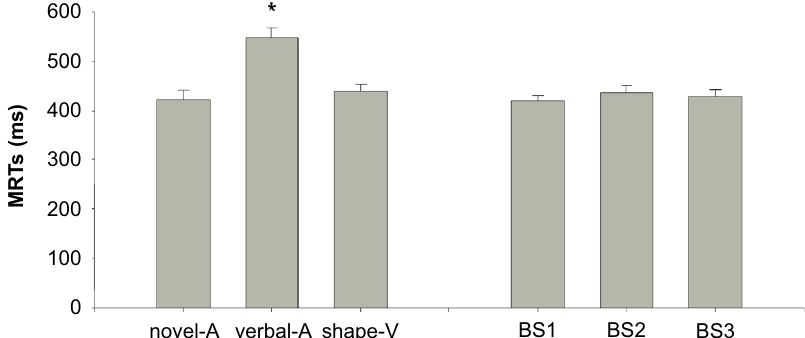
Figure 6. Reaction times for unisensory stimulus discrimination. Mean MRTs (+SEM) for each of the discrimination tasks: novel auditory sounds (novel-A), verbal auditory sounds (verbal-A), visual red shapes (shape-V), and the black visual symbol sets (BS1, BS2 and BS3). * p <